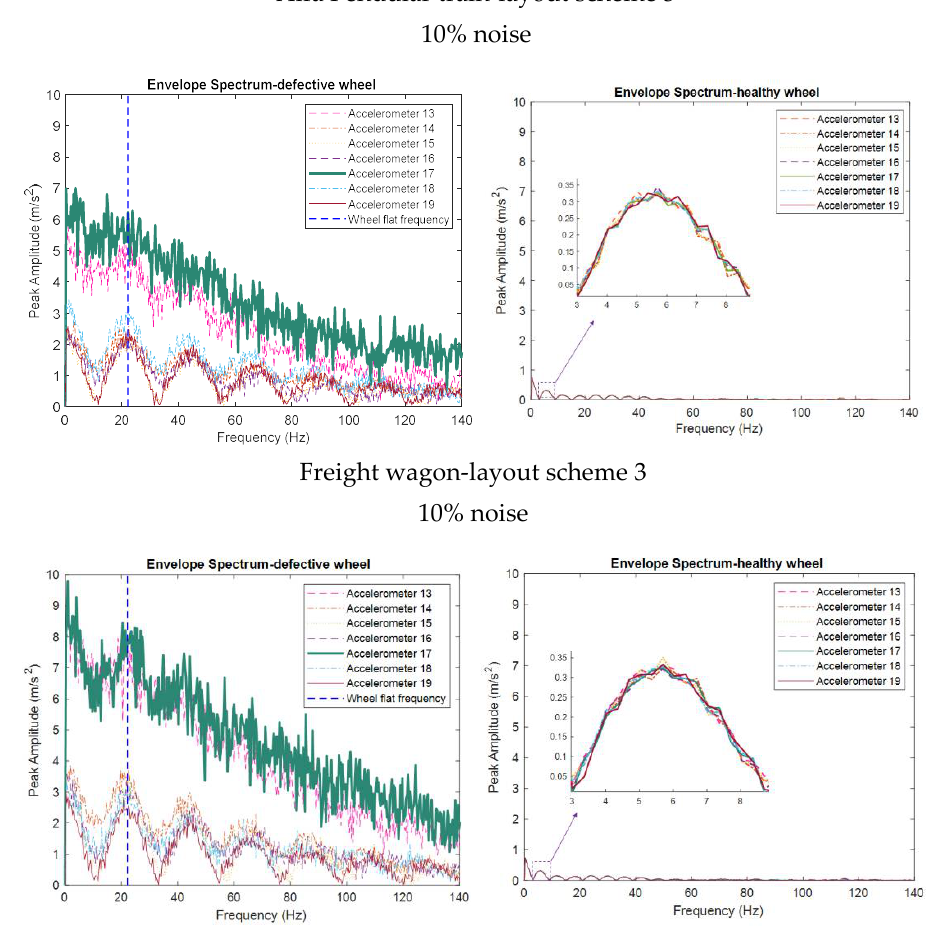
Figure 15. Envelope spectrum analysis for seven accelerometers (layout scheme 3) considering a defective and a healthy wheel of the Alfa Pendular and the freight wagon (noise = 10%).